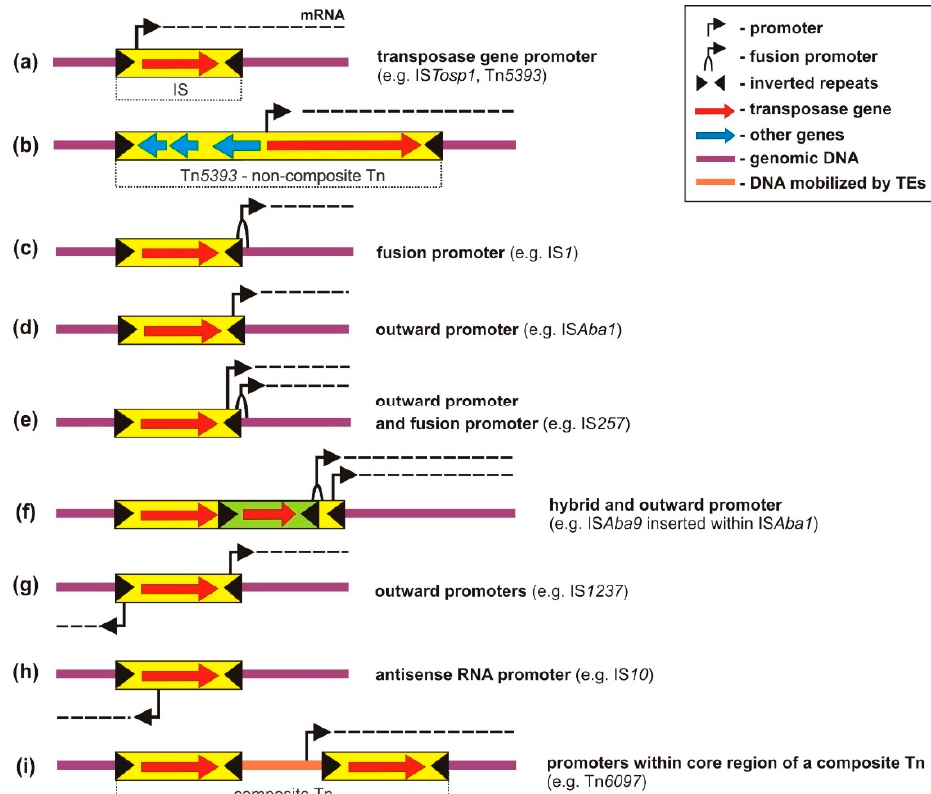
Figure 2. Promoters delivered or generated by TEs that enable or modulate the expression of nearby AR genes: ( a , b ) transposase gene promoters; ( c – g ) fusion and outward promoters; ( h ) antisense RNA promoters; ( i ) promoters within composite Tns. In the fusion and hybrid promoters, the − 35 and − 10 hexamers originate from the inserted IS and target DNA, respectively. See text for details.